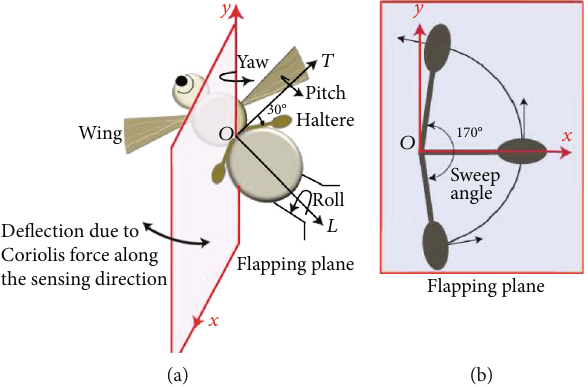
Figure 5: (a) A 3D picture of the fl y showing the fl apping and sensing planes. (b) The sweep angle of the haltere in the fl apping plane.